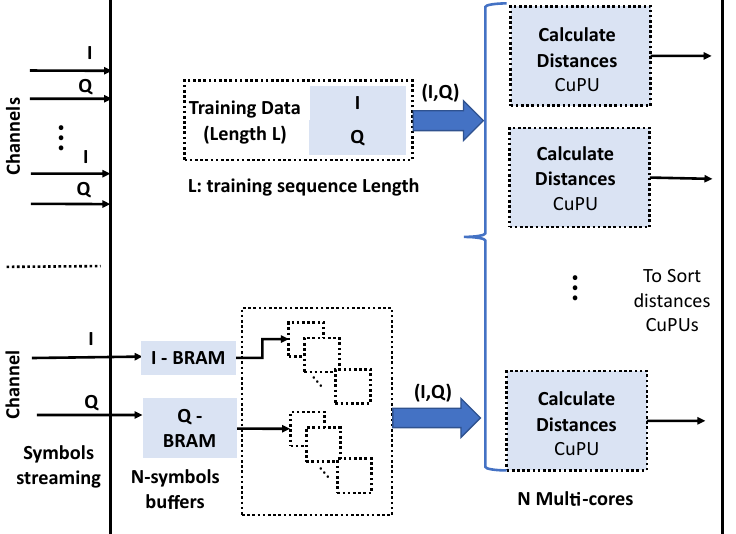
Figure 2. Calculate distance CuPUs by processing N symbols in parallel. The buffer converts the serial data in